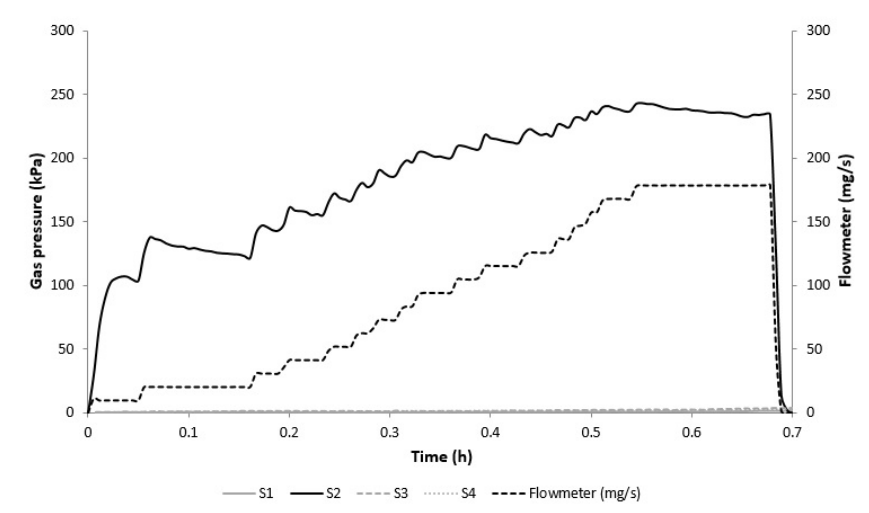
Figure 7. Evolution of borehole pressure after sample fracturing.